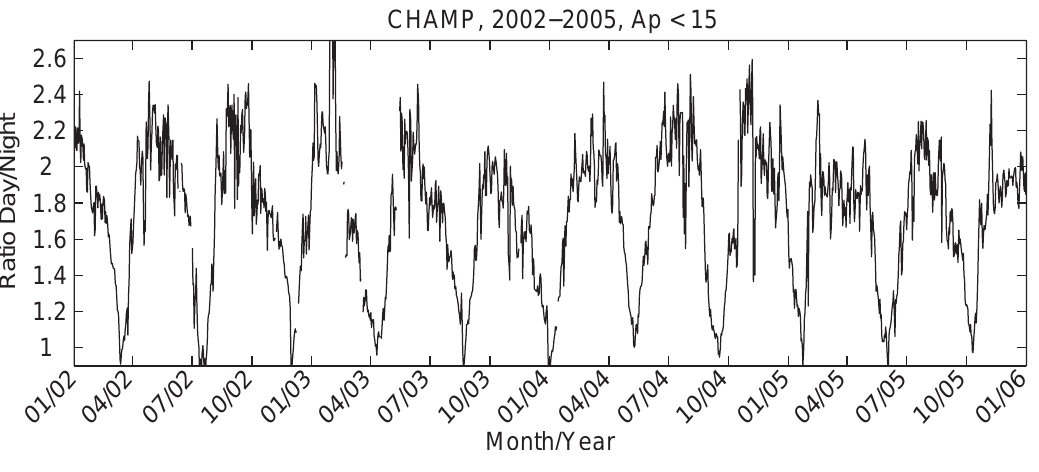
Fig. 4. Time series of the ratio between the day and night side densities for quiet days ( A p < 15). The density readings are longitudinally averaged daily